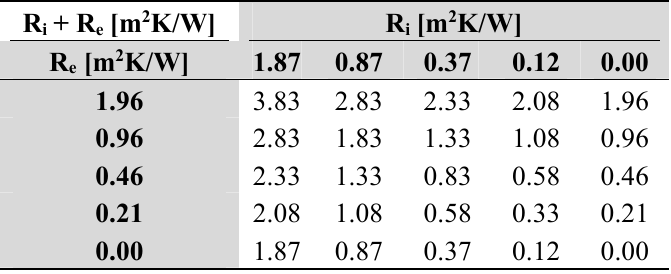
Table 3. Thermal resistance of the additional panels (R i , R e )—values assumed for the simulations (the values related to R i and R e are shown in bold in the first row and first column, respectively. The values of R Tot = R i + R e are shown in the